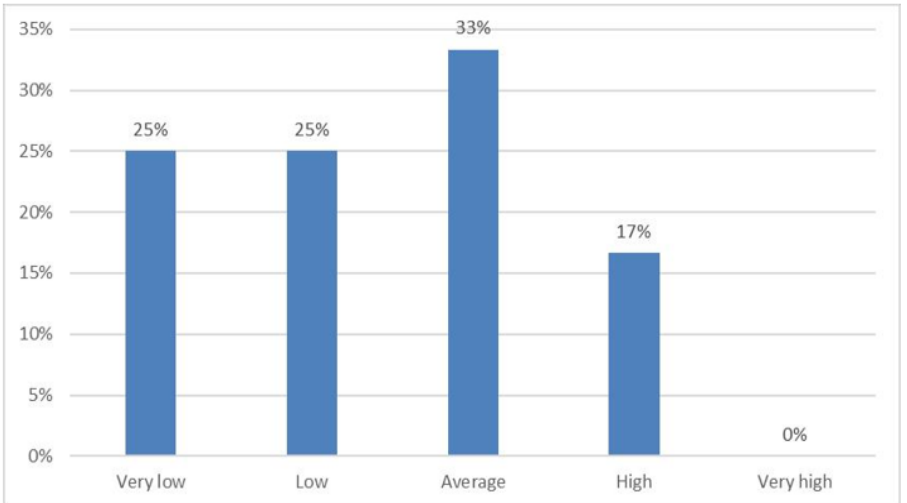
Figure 12. Long Lead Times and Delays in Delivery (%)